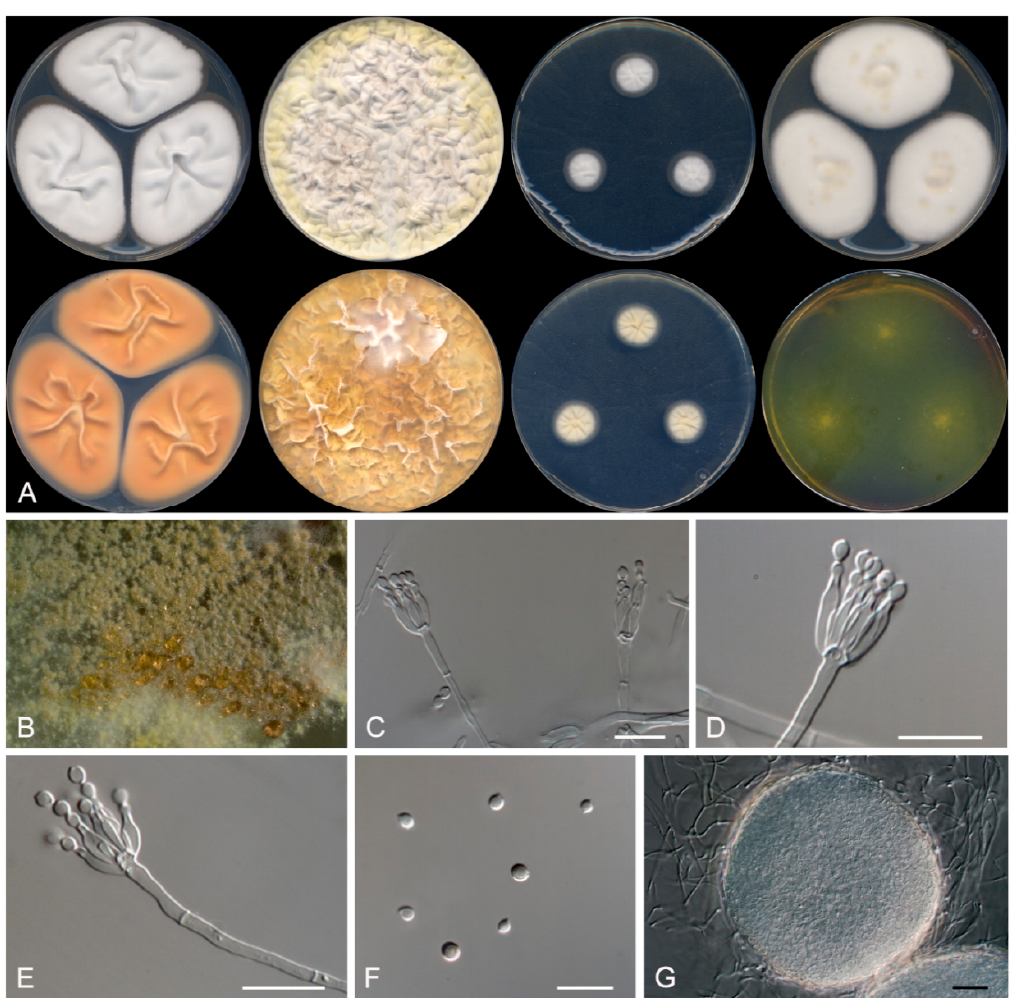
Figure 3. Morphological characters of Penicillium siccitolerans FMR 17,381 T . ( A ) Colonies after 14 days at 25 °C (top row, left to right: surface on CYA, YES, DG18, and MEA; bottom row, left to right: reverse on CYA, YES and DG18, and surface on CREA). ( B ) Detail of the colony on oatmeal agar (OA) under the stereomicroscope. ( C – E ) Conidiophores. ( F ) Conidia. ( G ) Sclerotium. Scale Bar: ( C – F ) = 10 μ m; G = 25 μ m.